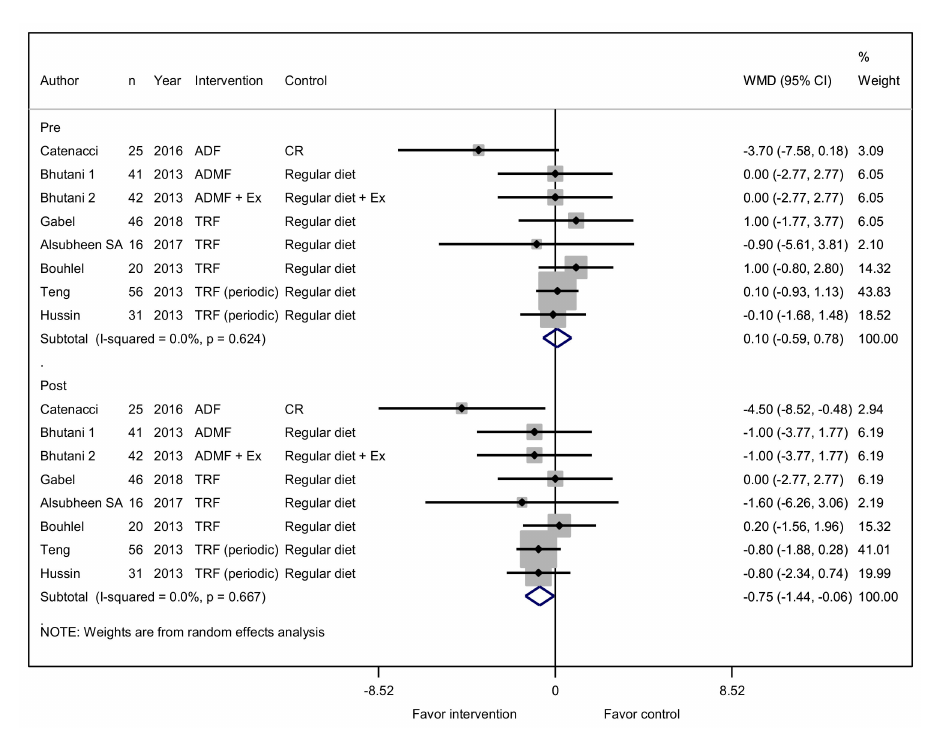
Figure 2. E ff ect of intermittent fasting (IF) versus a non-fasting control on body mass index (changes from baseline) in adults without chronic metabolic disease. The squares indicate the study-specific outcome estimates, and the size of the squares corresponds to the study’s weight in the meta-analysis. Horizontal lines denote the range of the 95% confidence interval. The diamonds indicate pooled estimates. Weights are from random e ff ects